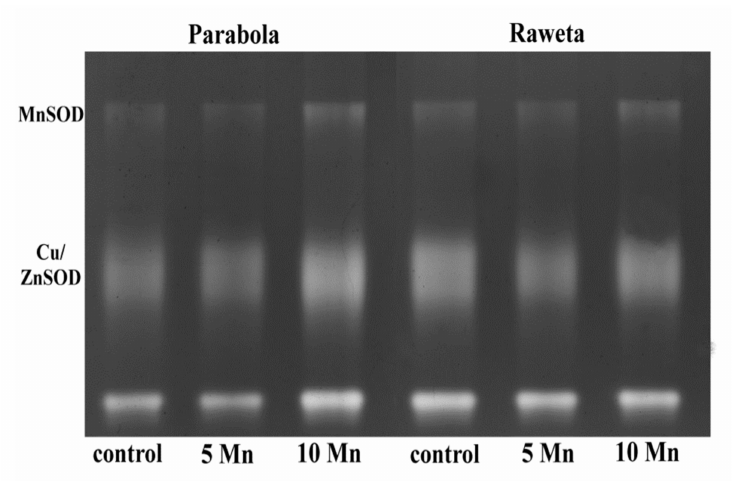
Figure 3. Patterns of SOD activity visualized by native PAGE in wheat leaves of Parabola and Raweta, grown in water (control) and at 5 and 10 mM MnCl 2